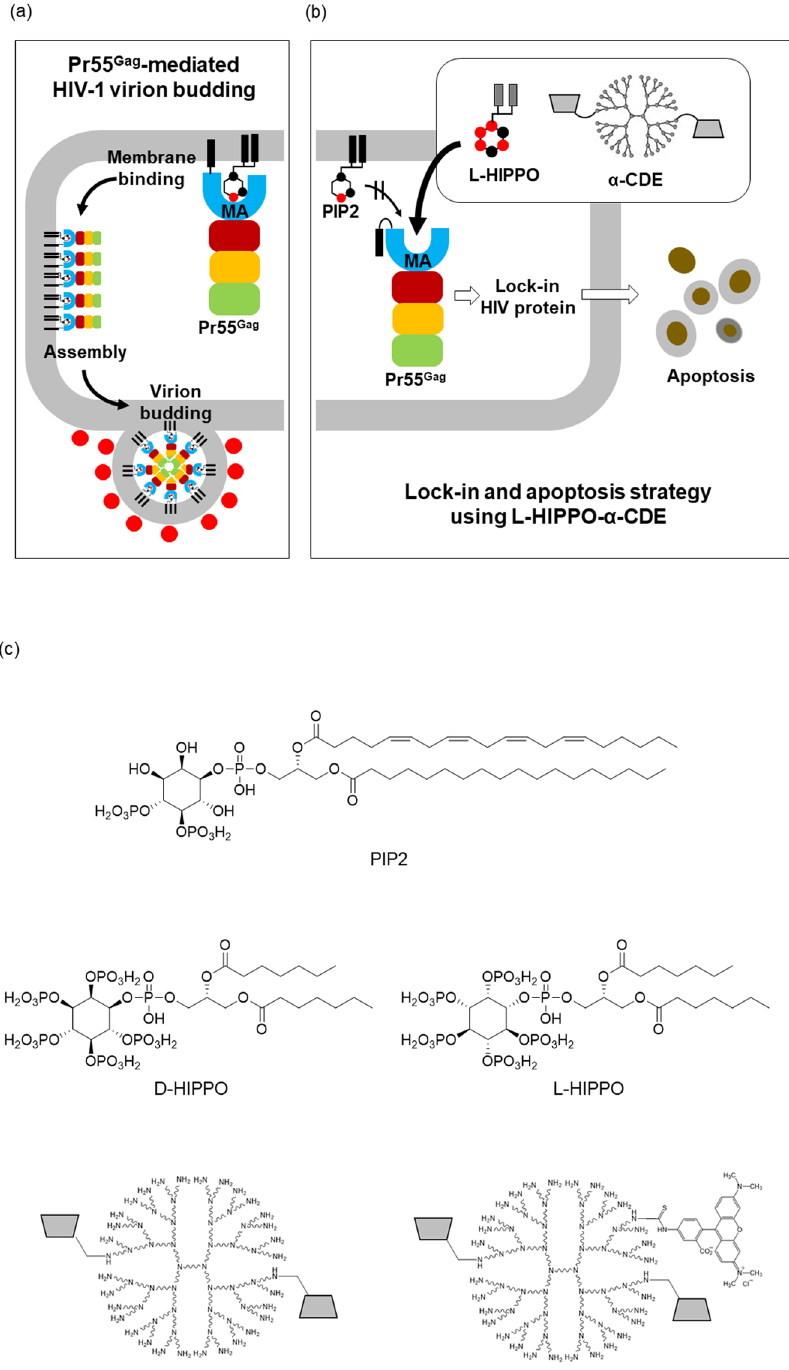
Figure 1. Lock-in and apoptosis strategy using a cyclodextrin/dendrimer conjugate α -CDE and a man-made molecule L-HIPPO. ( a ) HIV-1 virion budding is mediated by viral protein Pr55 Gag that binds to a membrane phospholipid PIP2. PIP2-bound Pr55 Gag assembles in the membrane to form virions. ( b ) α -CDE delivers L-HIPPO into HIV-1-infected cell where L-HIPPO antagonizes the PIP2-Pr55 Gag binding to interfere with virus budding. The infecting HIV-1 is enclosed and dies with the apoptosis of the host cell. ( c ) Structures of PIP2, D-HIPPO, L-HIPPO, cyclodextrin/dendrimer conjugates ( α -CDE), and α -CDE conjugated with TRITC ( α